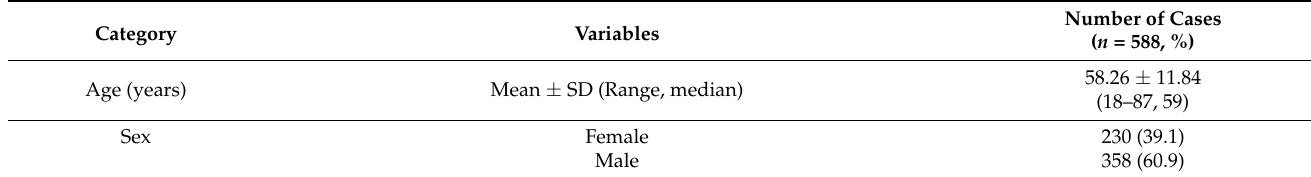
Table 1. Clinicopathologic features of 588